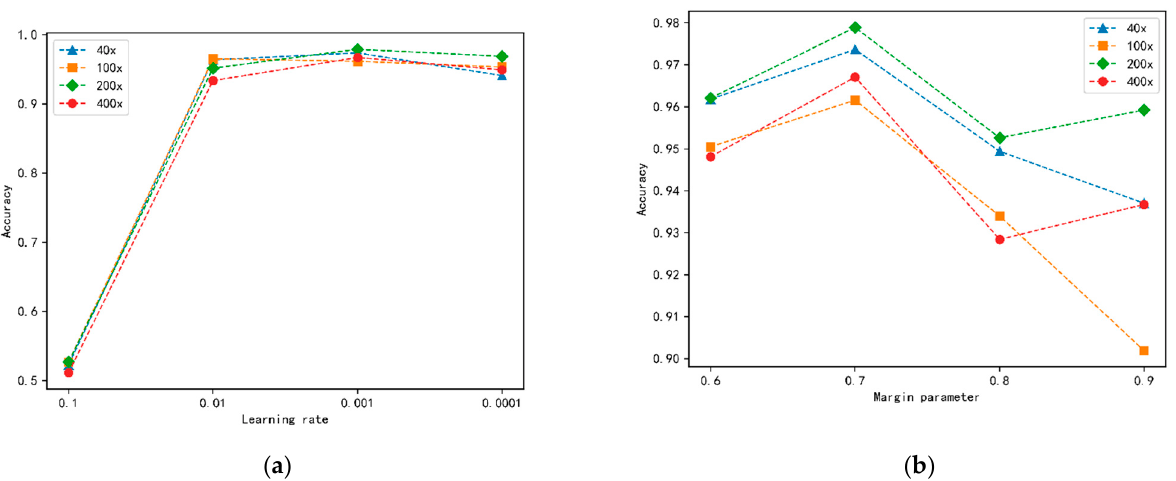
Figure 7. ( a ) A comparison of the classification accuracy of our proposed method at different learning rates at four different magnifications database. ( b ) A comparison of the classification accuracy of our proposed method at different learning rates at four different magnifications database.